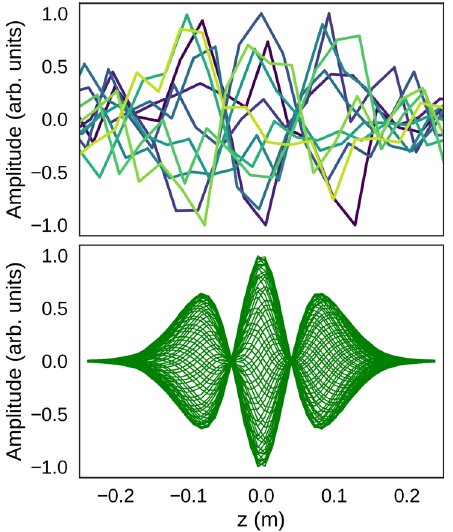
FIG. 5. Head-tail mode patterns from LHC measurements (top) and simulations (bottom) for a single bunch at the top energy (6.5